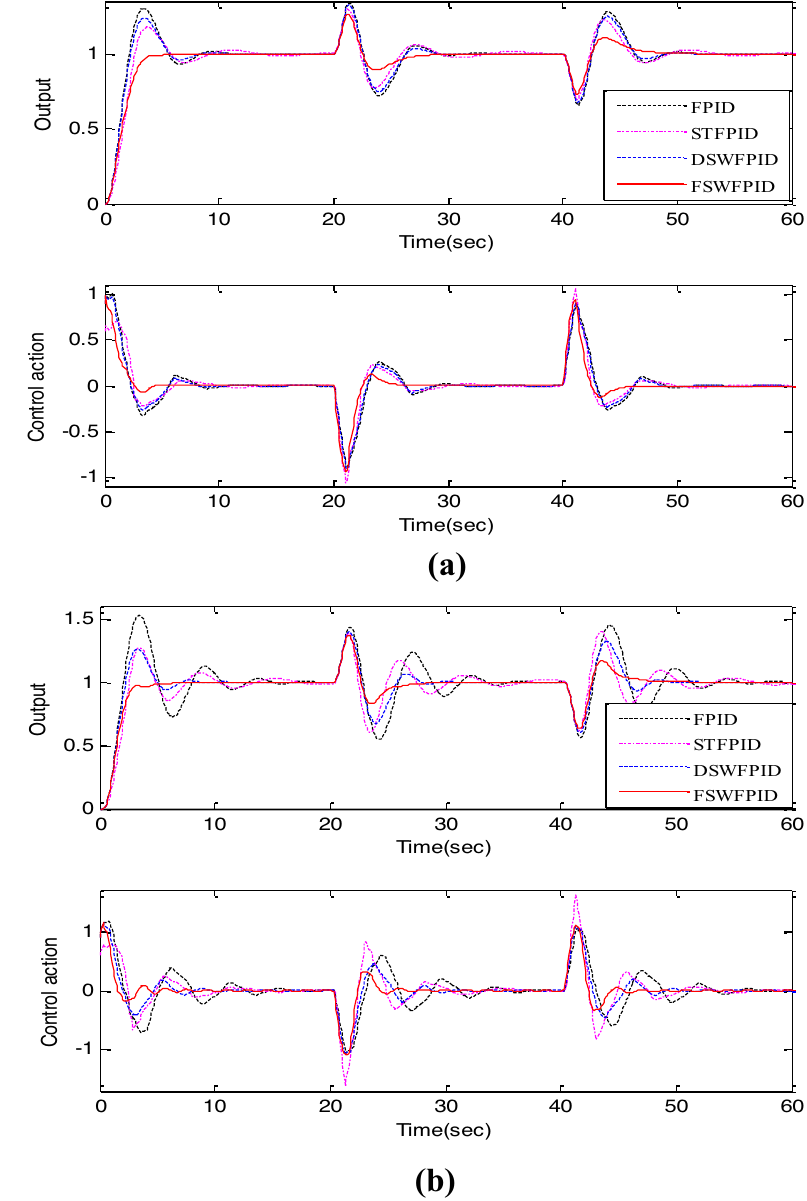
Fig. 5 Responses and control actions for Model I using 49 rules during set point response and with load variation for a L = 0.05 s, b L = 0.3